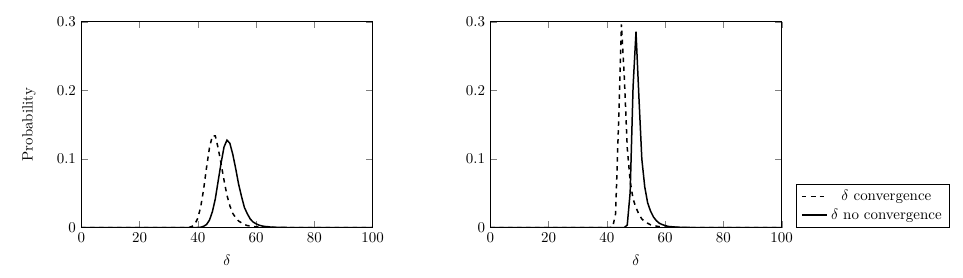
Figure 7: Distribution of δ when there is no convergence (plain) and when there is convergence (dashed). Left: N = 200. Right: N = 2000. SNR = 0 .